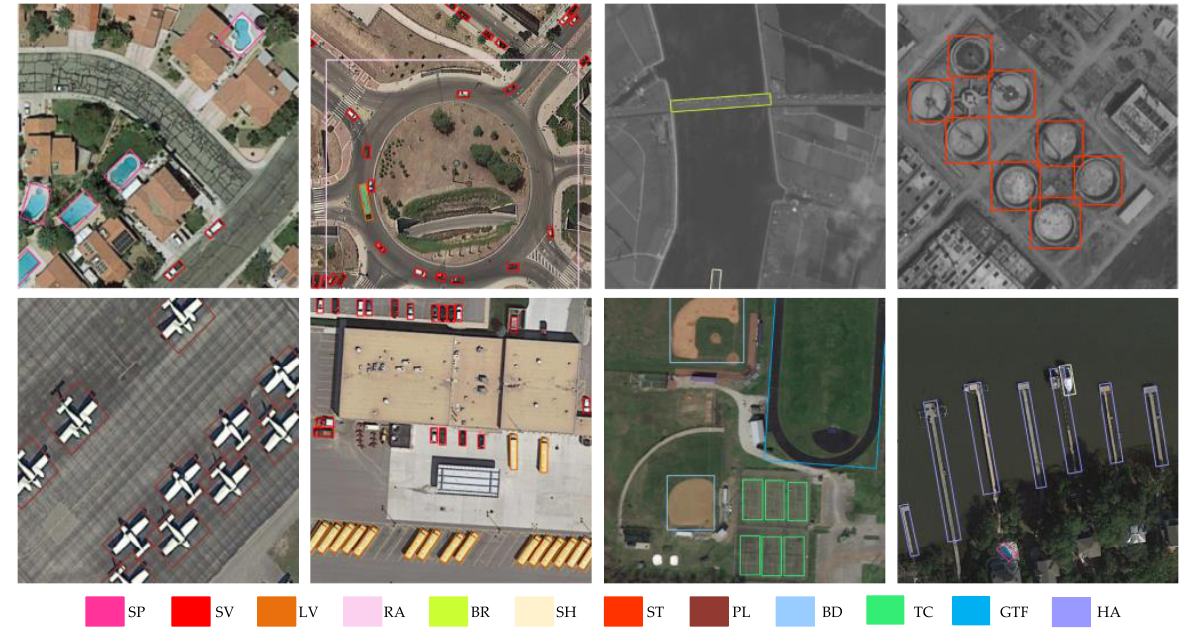
Figure 10. Visualization results of our method.